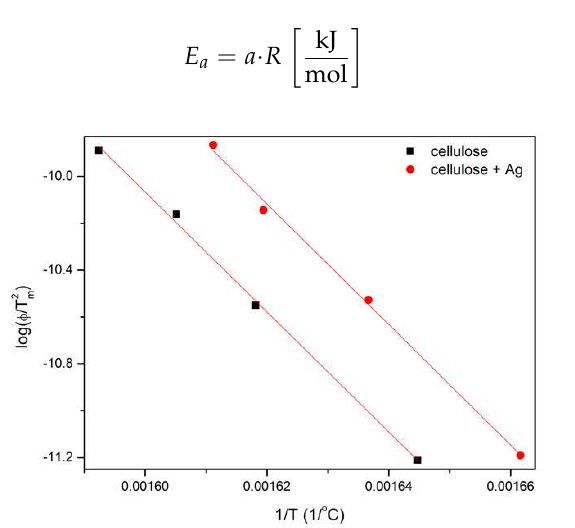
Figure 9. Plot ln(ϕ/ T m2 ) = f (1/ T m ) for the Kissinger–Akahira–Sunose (KAS) method.